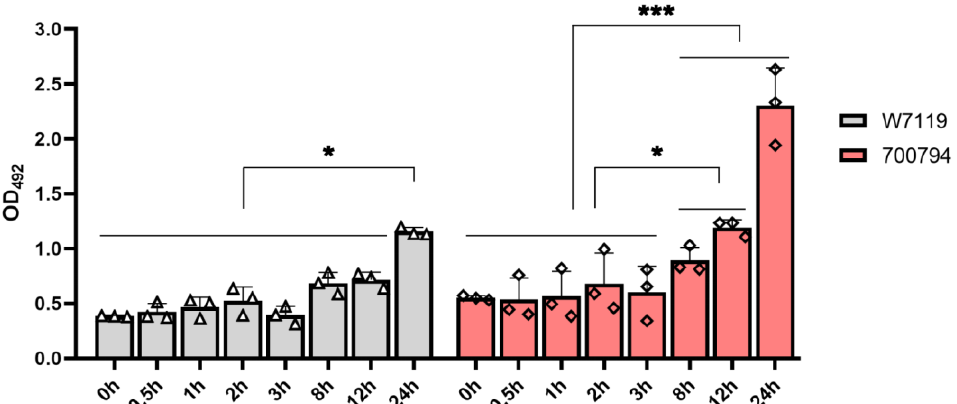
Figure 2. Cytotoxicity induced by S. suis infection. PAM-Tang cells were infected with S. suis vir- 700794 or S. suis avir-W7119 at MOI = 1 and incubated for 0.5, 1, 2, 3, 8, 12, or 24 h, negative control expressed as 0 h. The triangles represent S. suis W7119 infection group ( n = 3), diamonds represent S. suis 700794 infection group ( n = 3). Culture supernatants were measured for their LDH activity and expressed as optical density (OD 492 ). Each number represents the mean ± SD generated from three cell supernatants at each time point, and experiments were repeated three times. significance was determined using two- way ANOVA and Tukey’s multiple -comparison test; ns: not significant; *: p < 0.05; ***: p < 0.001.